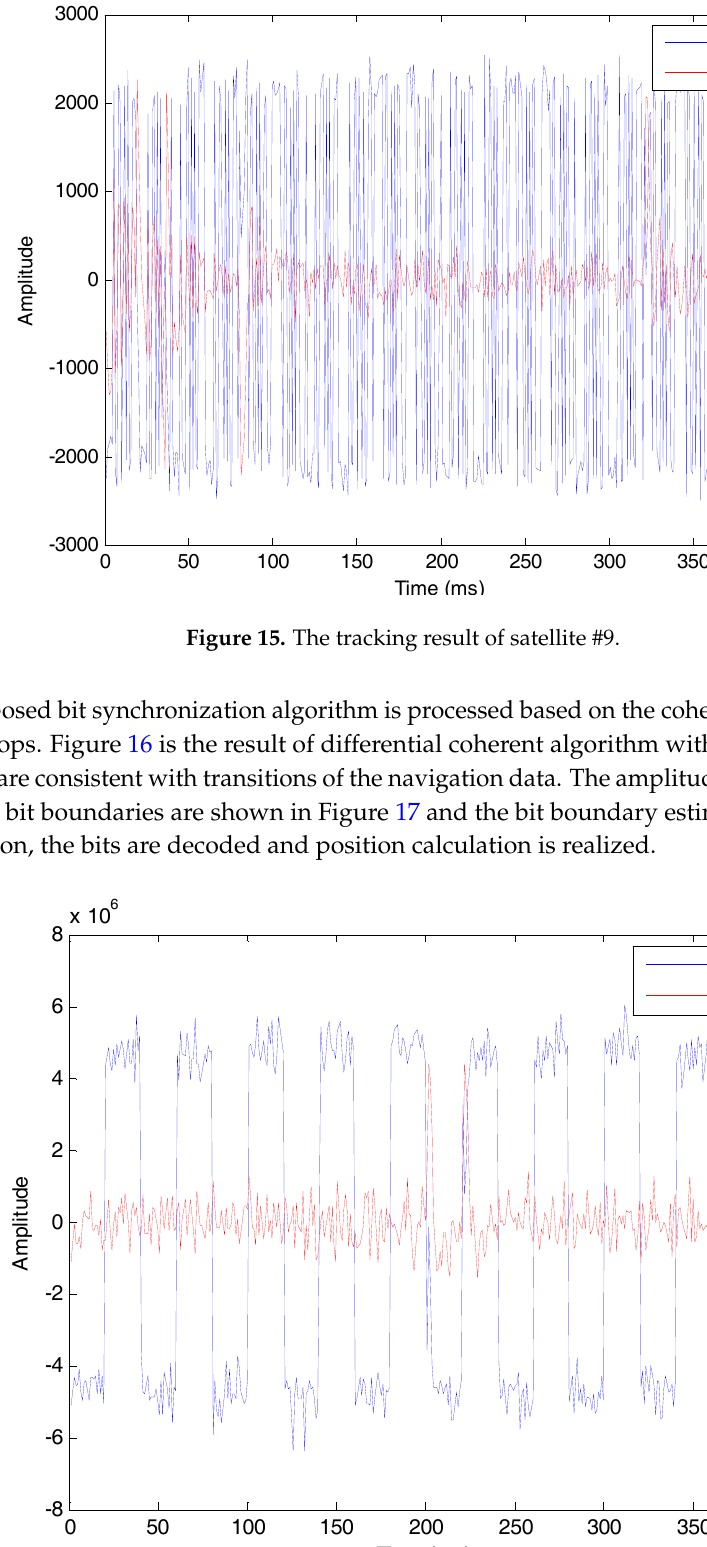
15 of 18 Figure 14. The BeiDou B1I receiver test platform. Table 3. Parameters used in real data tests. Parameters